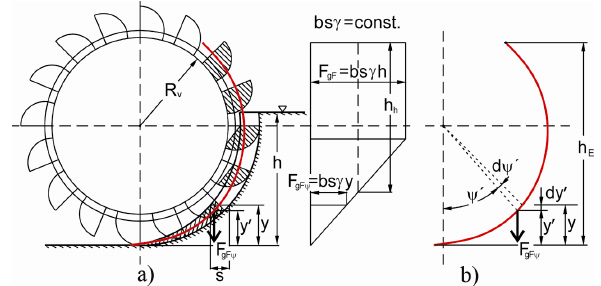
Fig. 2. Scheme for evaluation of power P h (Durst, Vogt